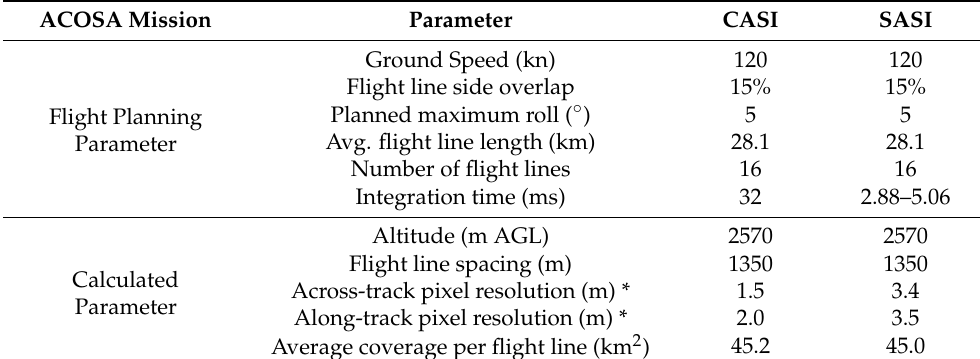
Table 2. Sample flight planning parameters for the study region for both CASI and SASI modified from